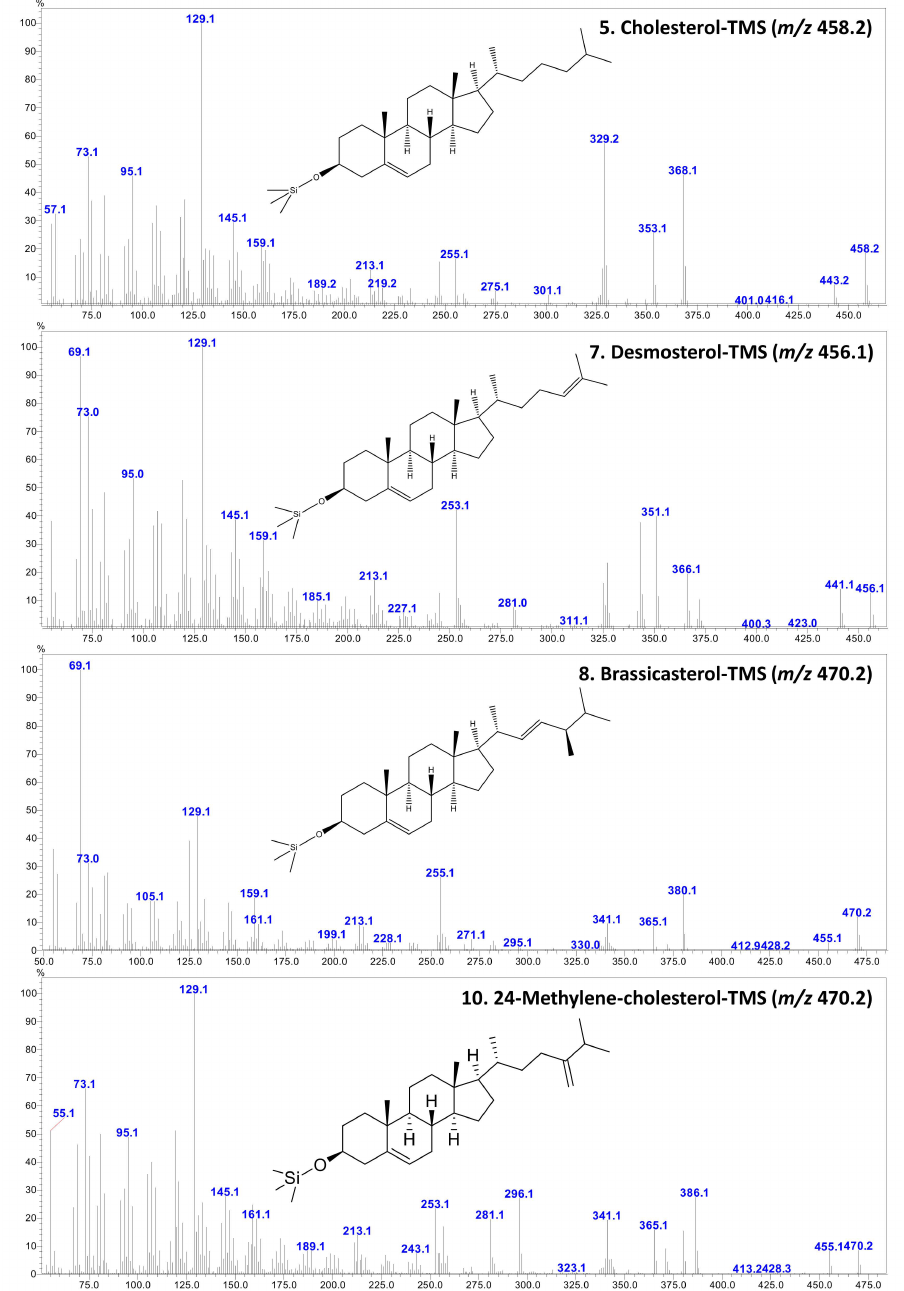
Figure 3. A representative mass spectrometric fragmentation pattern of major sterols (trimethylsiloxy [TMS] derivatives) identified and quantified from the shellfish species. The numbers 5, 7, 10, and 10 correspond to peak numbers in Table 2 and Figure